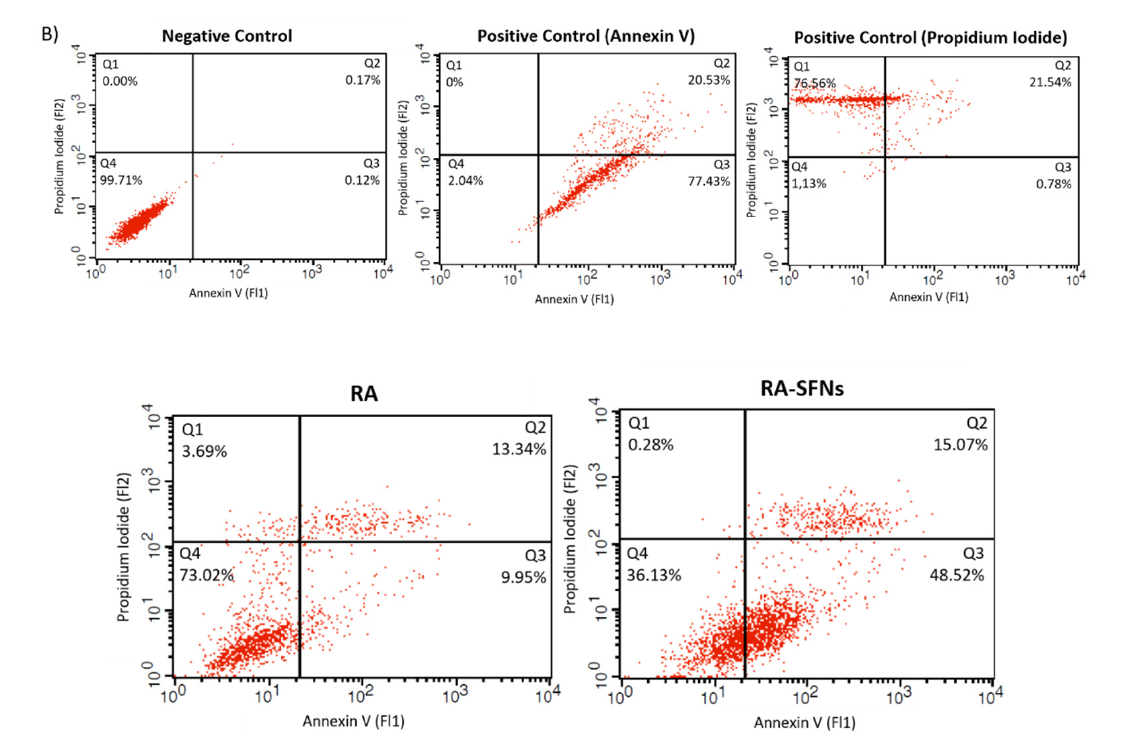
Figure 12. Flow cytometry analysis of apoptosis rate in HeLa ( A ) and MCF-7 ( B ) cells after 24 h of treatment with free RA and RA-SFNs. Cells not treated were used as negative control, cells treated with camptotecin were used as apoptosis positive control (annexin V) and cells not treated, fixed and stained were used as necrosis positive control (propidium iodide).